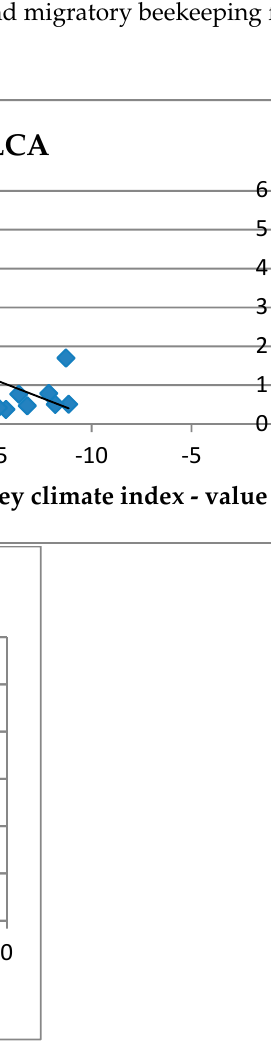
Figure 3. Statistical correlation between wildflower honey climate index and yield, LCA results concerning CC impact category, and supplemental feeding.